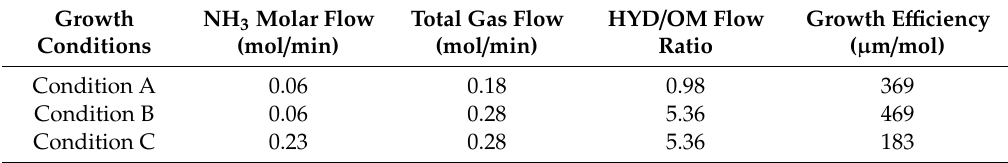
Table 1. OMVPE parameters associated with growth conditions A, B, and C.